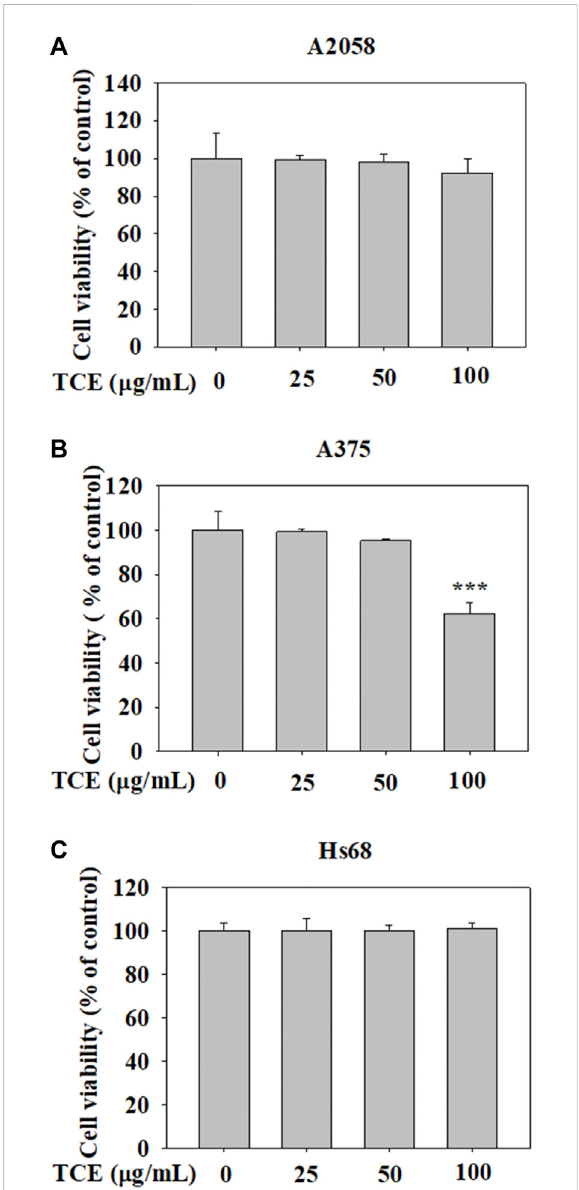
FIGURE 1 The effects of TCE cell viability. (A) A2058, (B) A375 cells and (C) normaldermal fi broblastHs68weretreatedwithTCE(0,25,50, 100 μ g/ml), respectively, for 24 h by MTT assay. The values represent the means ± SD of at least three independent experiments. Comparisons were performed using two-way ANOVA with post hoc Turkey ’ s test (*** p <